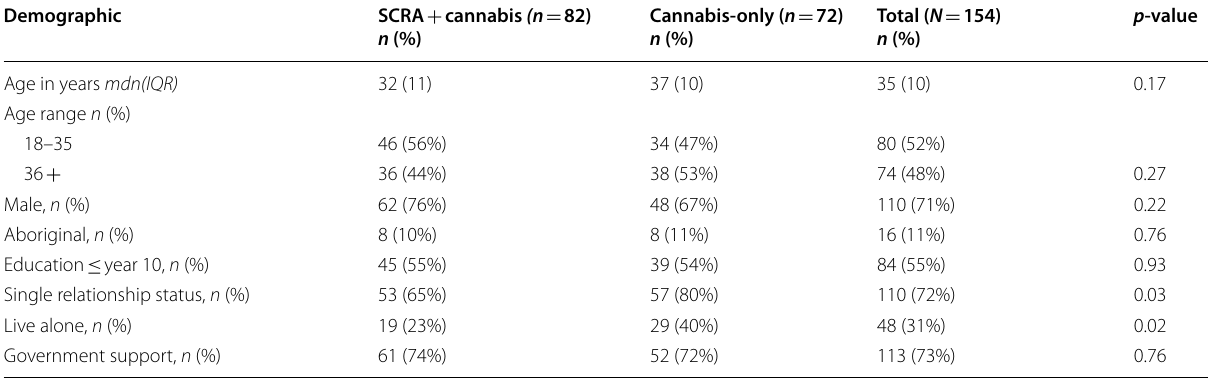
Table 1 Sociodemographic characteristics of 154 participants undergoing treatment for cannabis use in New South Wales, Australia Demographic